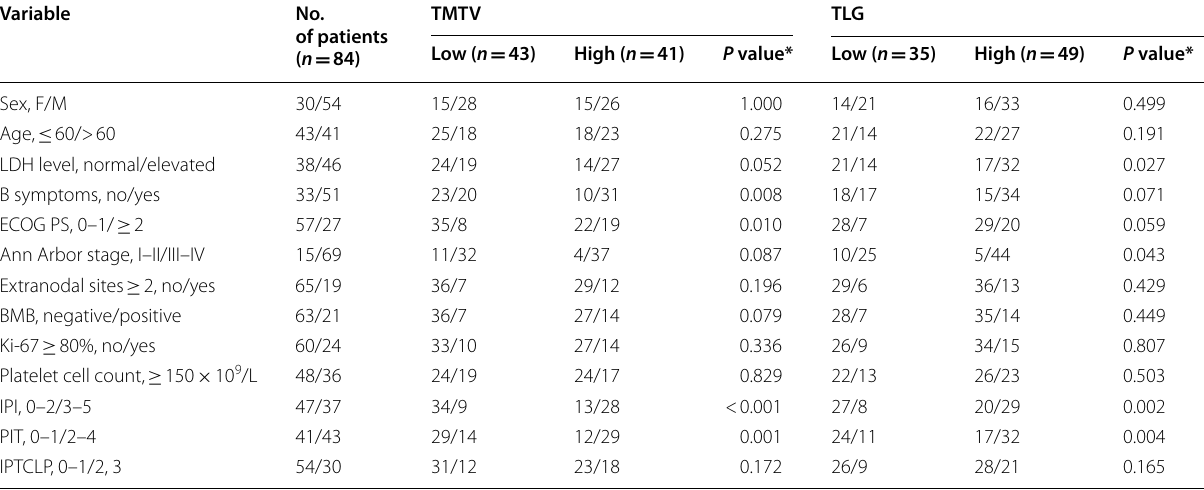
A chi-square test was used to test the significance of the association between clinical data and the baseline TMTV and TLG LDH lactate dehydrogenase, ECOG PS Eastern Cooperative Oncology Group performance status, BMB bone marrow biopsy, IPI International Prognostic Index, PIT prognostic index for T-cell lymphoma, IPTCLP International peripheral T cell lymphoma Project, MTV metabolic tumor volume, TLG total lesion